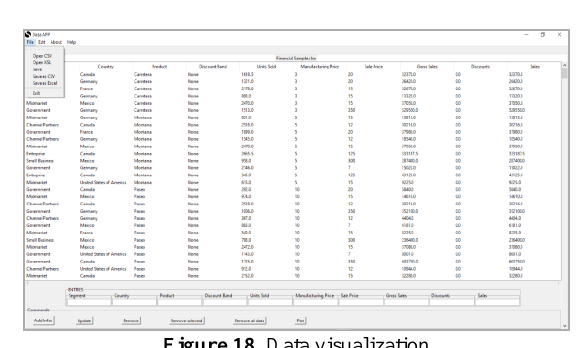
Figure 18 . Data visualization